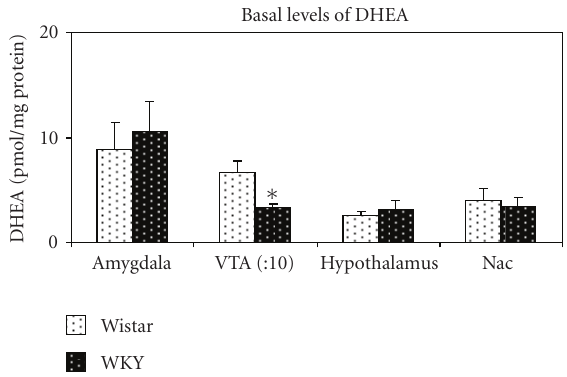
Figure 1: Mean basal levels of DHEA ( ± SEM) of 34-35 day old Wistar and WKY rats. Levels in the VTA are divided by ten for presentation purposes. ∗ P < . 05.